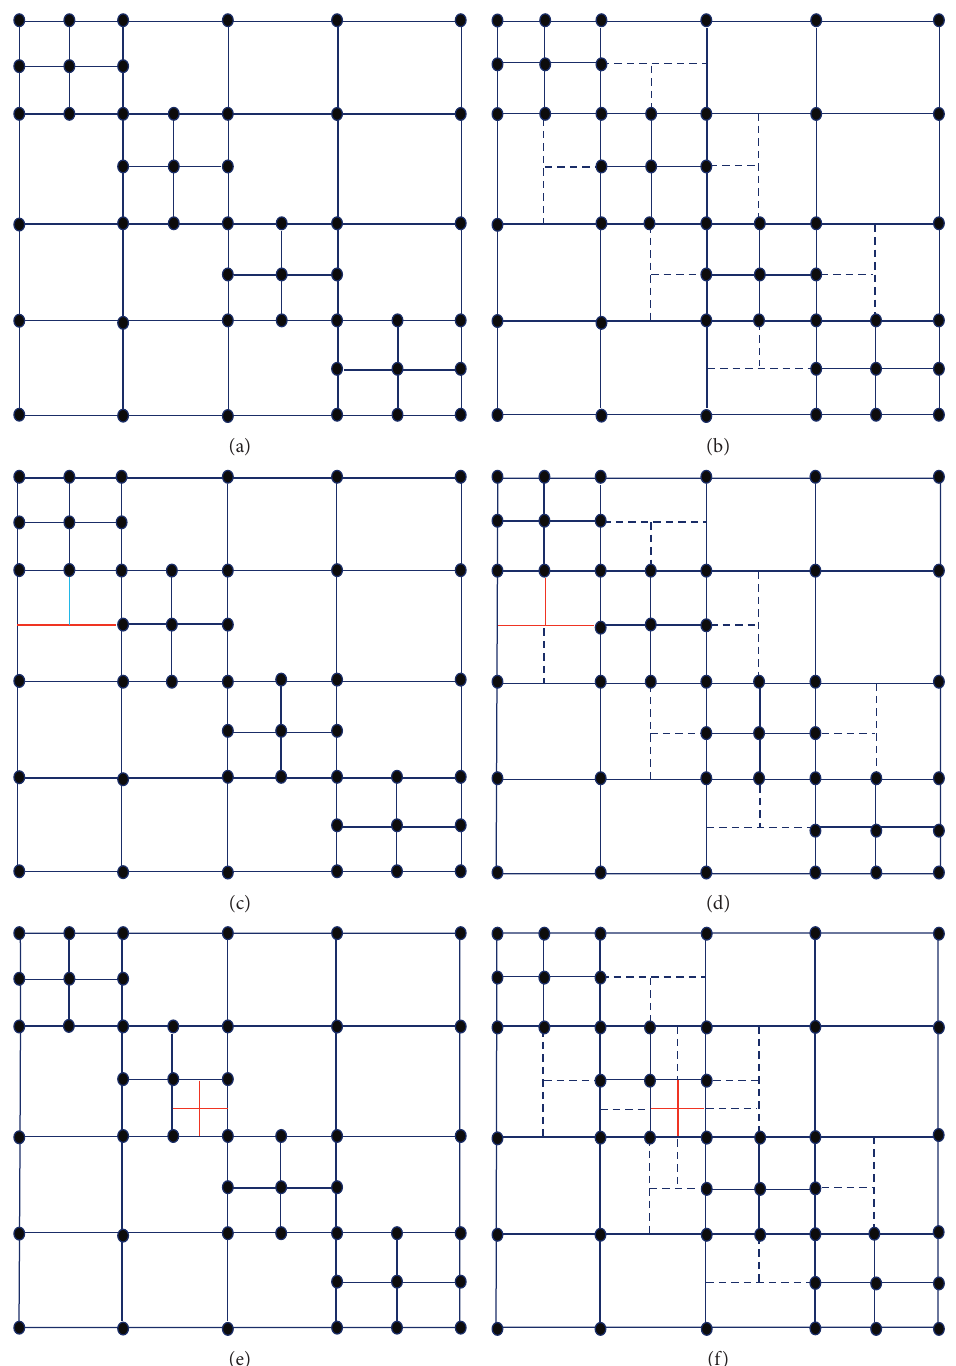
Figure 11: Local refinement of a diagonal T-mesh. (a) Design-suitable T-mesh T 1 . (b) Extended T-mesh T 1 e . (c) Insert an edge (red line) T 2 . (d) Extended T-mesh T 2 T 2 . (f) Extended T-mesh T 2 e . (e) Insert an edge (red line) e